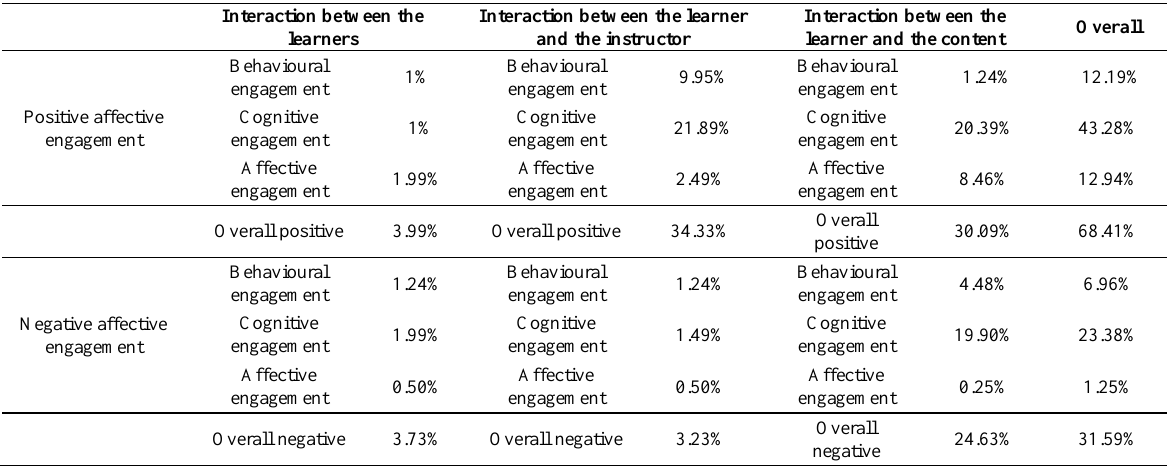
Table 5. Percentages of positive and negative affective engagement in synchronous lectures (N= 402 units). Interaction between the Interaction between the learner learners and the